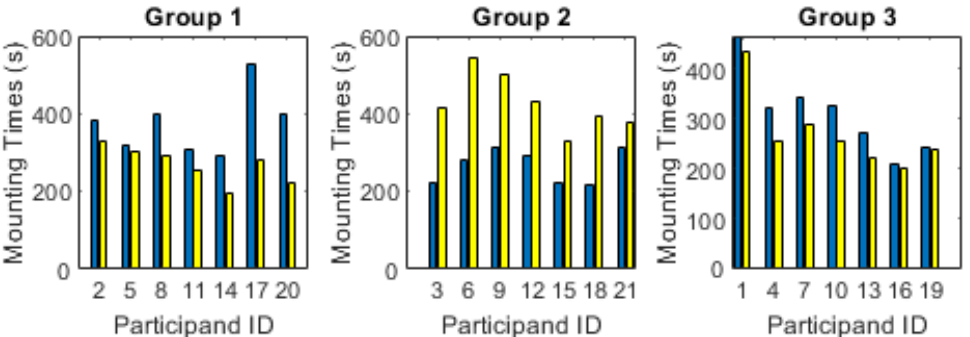
Figure 8. Mounting times of each group. Blue and yellow bars represent the original and proposed system, respectively. Group 1 started with the original, Group 2 started with the proposed and Group 3 already had